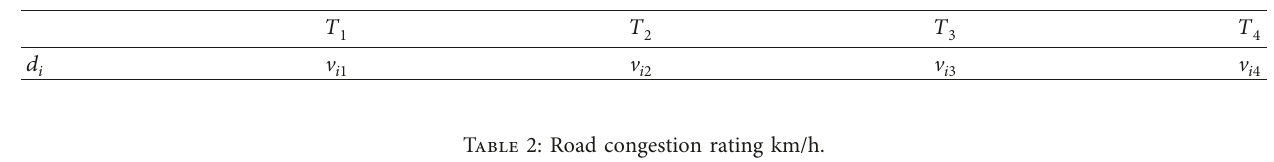
Table 1: Time-varying road speed matrix.